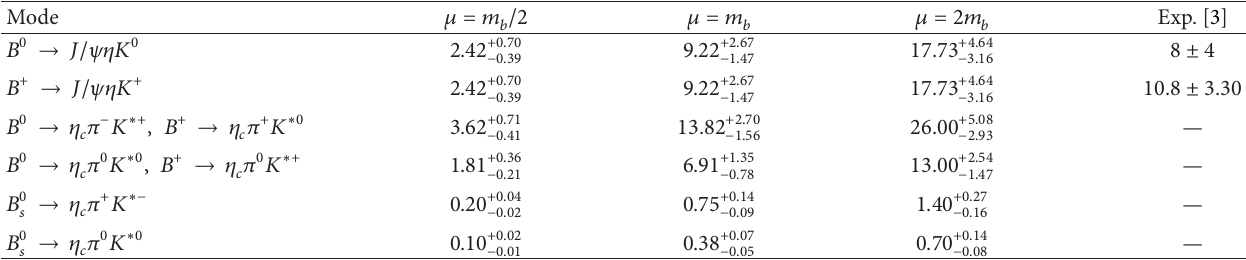
Table 2: Branching ratios of 𝐵 → 𝐽/𝜓𝜂𝐾 (in units of 10 −5 ) and 𝐵(𝐵 𝑠 ) → 𝜂 𝑐 𝜋𝐾 ∗ (in units of 10 −4 ) decay by using the Dalitz plot analysis.